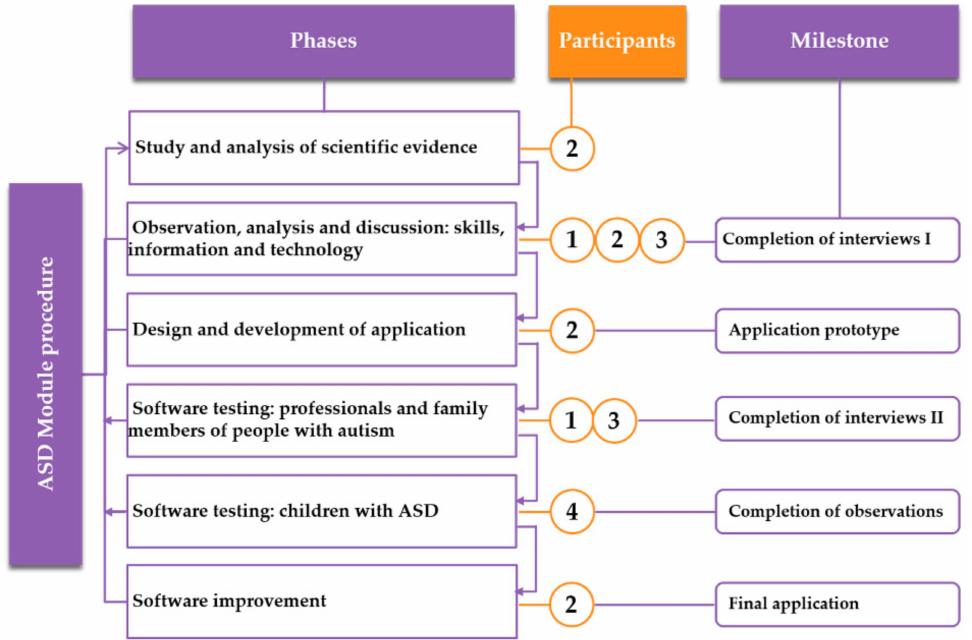
Figure 1. Study procedure (phases, participants, and